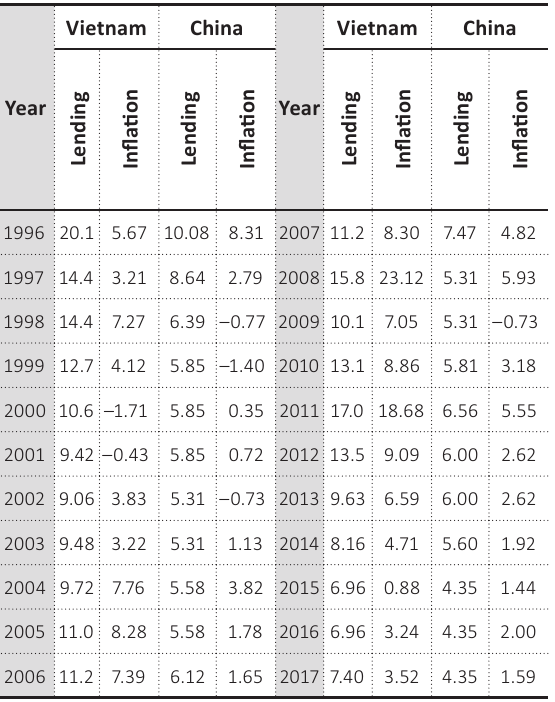
Table 1. Lending interest and inflation rates (unit %) Source: World Bank’s World Development